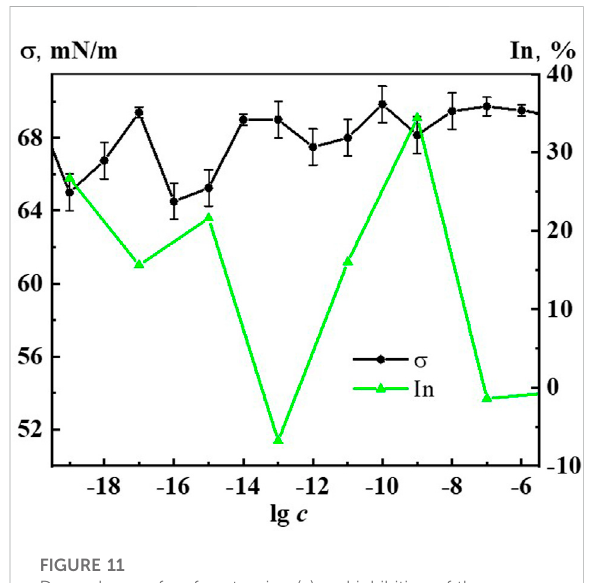
FIGURE 11 Dependence of surface tension ( σ ) and inhibition of the abundance of Chlorella vulgaris green algae (In) on concentration (c, M) of the Dox